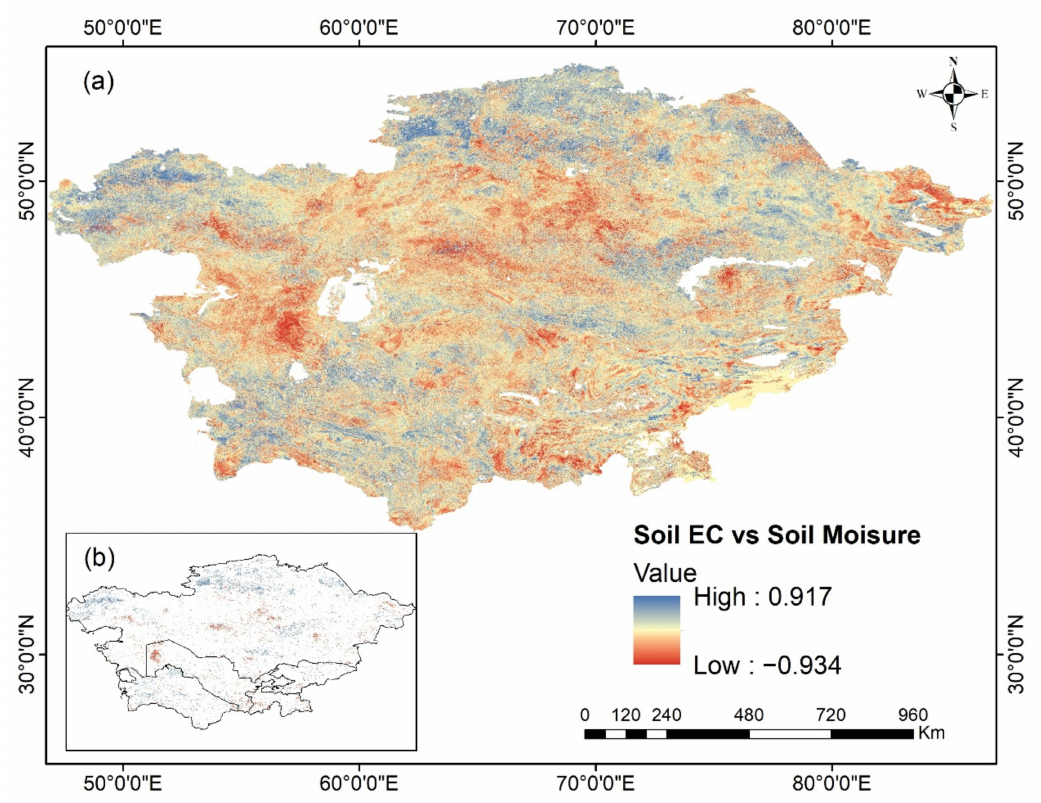
Figure 9. ( a ) Soil EC correlation to soil moisture, and ( b ) significant changes during